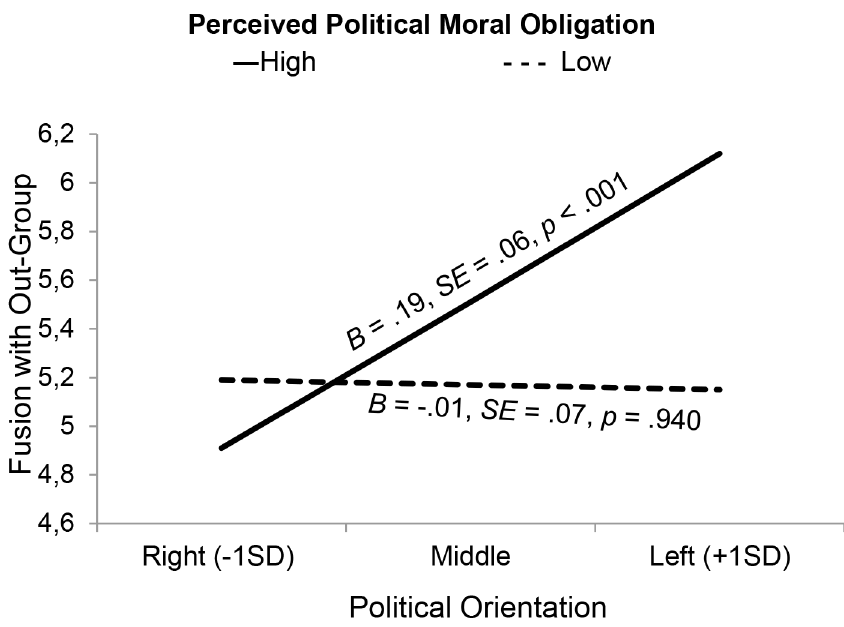
Fig 5. In Study 4, Leftist political orientation predicted more fusion with the Kurdish out-group when aspiring foreign fighters experienced that they had a high moral obligation to support the Kurds.